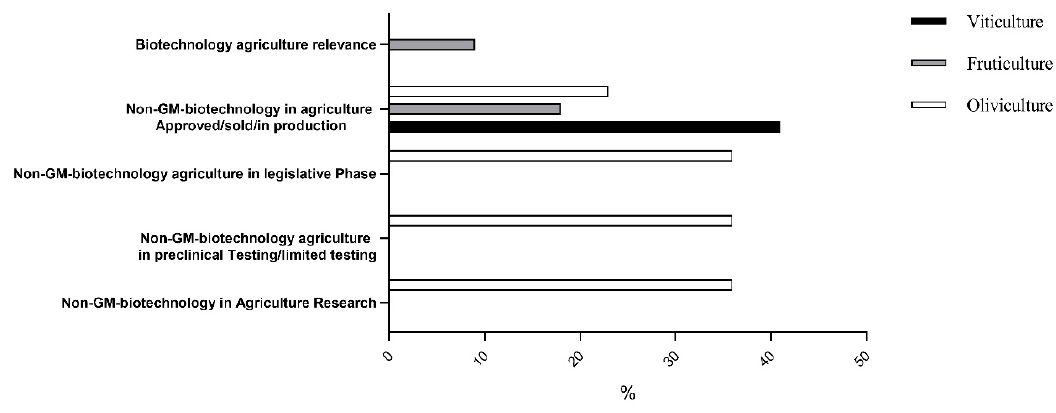
Figure 5. Sector usage of biotechnology techniques applied in the business companies studied. Source: Author’s calculation from the research dataset.